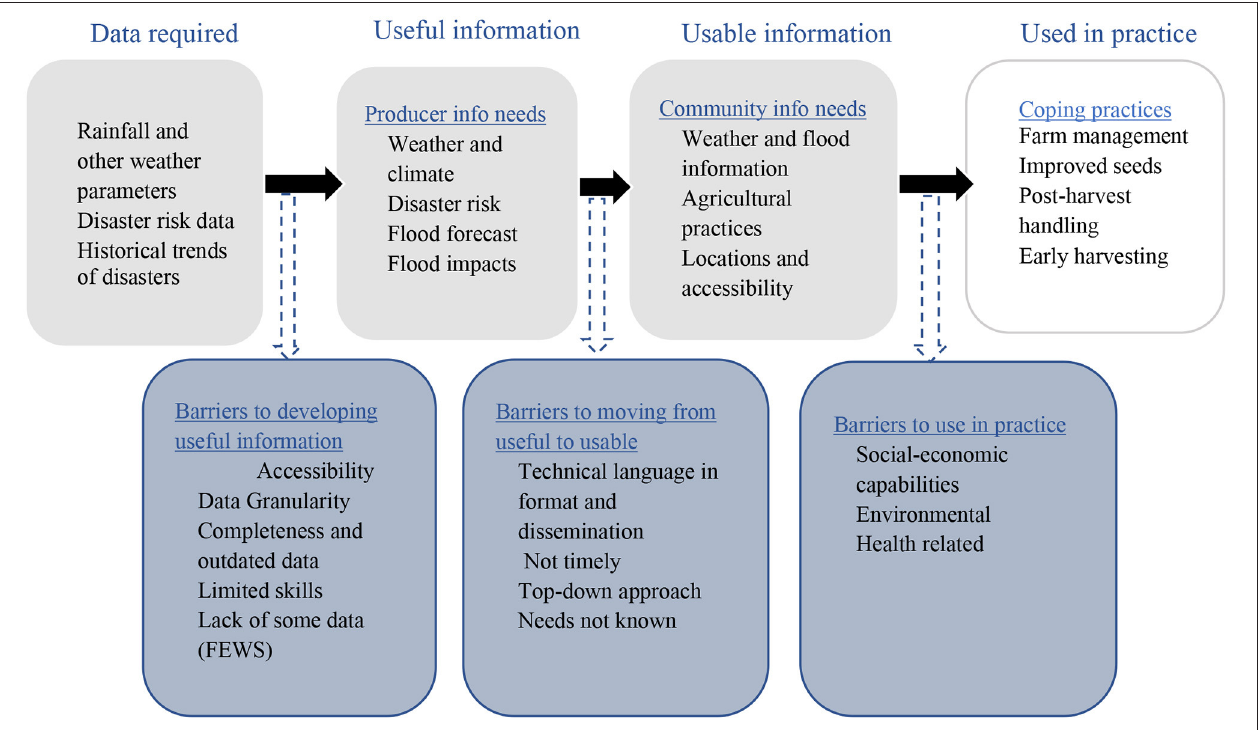
FIGURE 6 | Components that would be required to achieve a more coordinated institutional responses and flow of information to ensure useful and usable information is produced/provided and used in practise: the component headings have been adopted from Vincent et al. (2020) and Van Den Homberg et al. (2017) while their contents are based on findings from